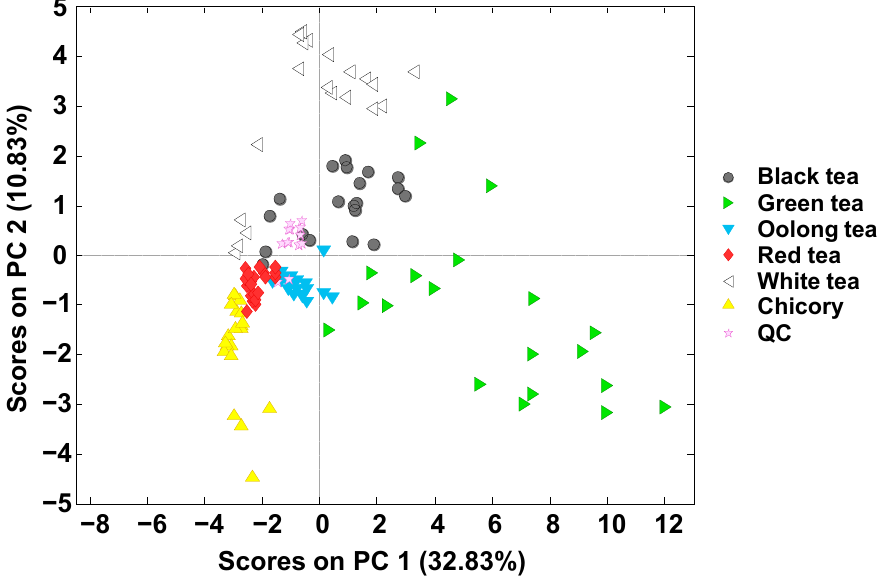
Figure 2. PCA score plot of PC1 versus PC2 when using targeted HPLC-UV polyphenolic profiles as sample chemical descriptors.